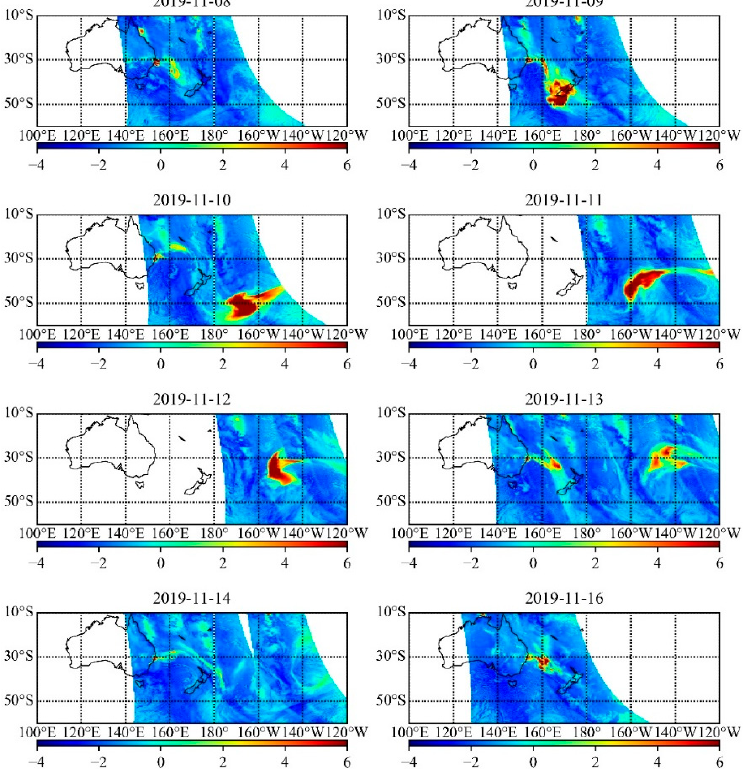
Figure 12. Distribution of AAI from TROPOMI observations of the Australian wildfires from 8 to 16 November 2019, showing biomass burning transported by winds in the atmosphere.